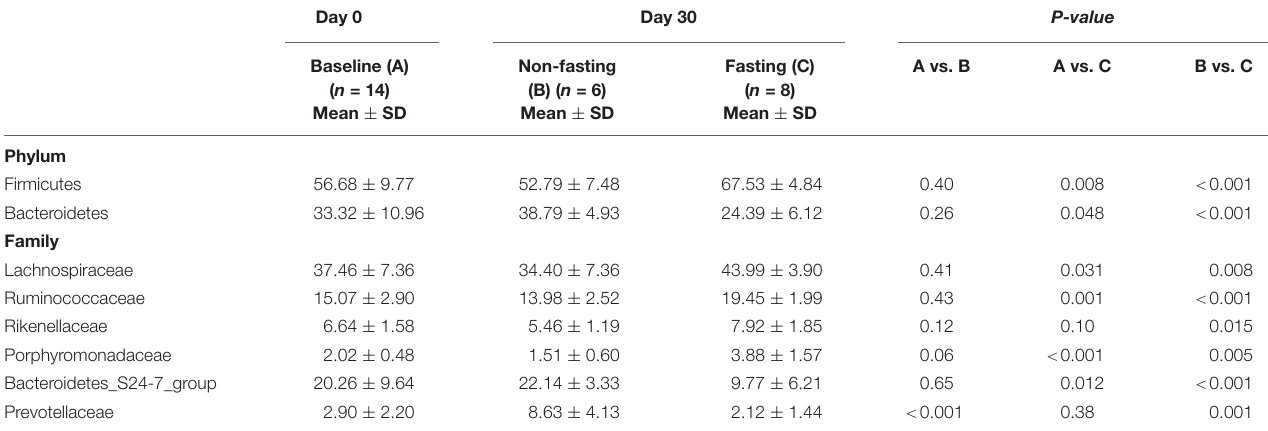
TABLE 1 | Changes in relative abundance of LefSe-identified taxa during